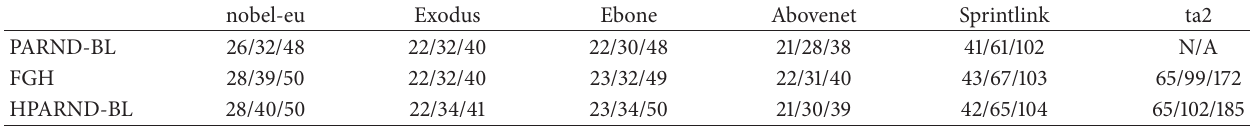
Table 4: Number of powered-on network elements (nodes/links/PICs)—logarithmic 𝑃 RP V ,𝑇( V ) , 𝑃 𝐶 V = 200 W. nobel-eu Exodus Ebone Abovenet Sprintlink ta2 PARND-BL